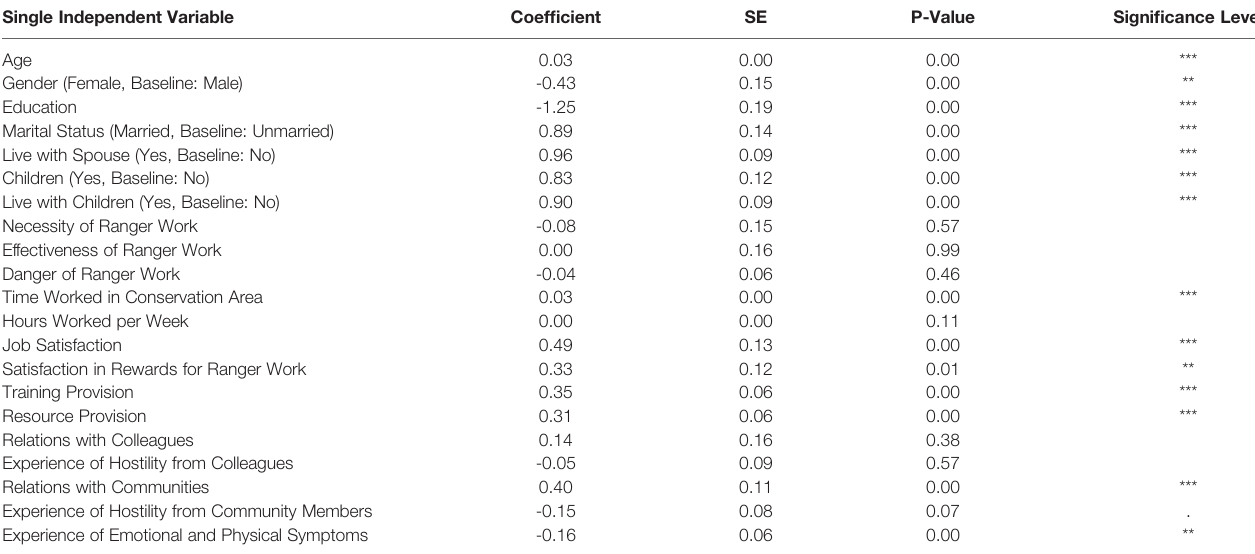
TABLE 3 | Coef fi cients, standard errors (SE) and p-values for each model in our series of mixed effects logistic regression models. Single Independent